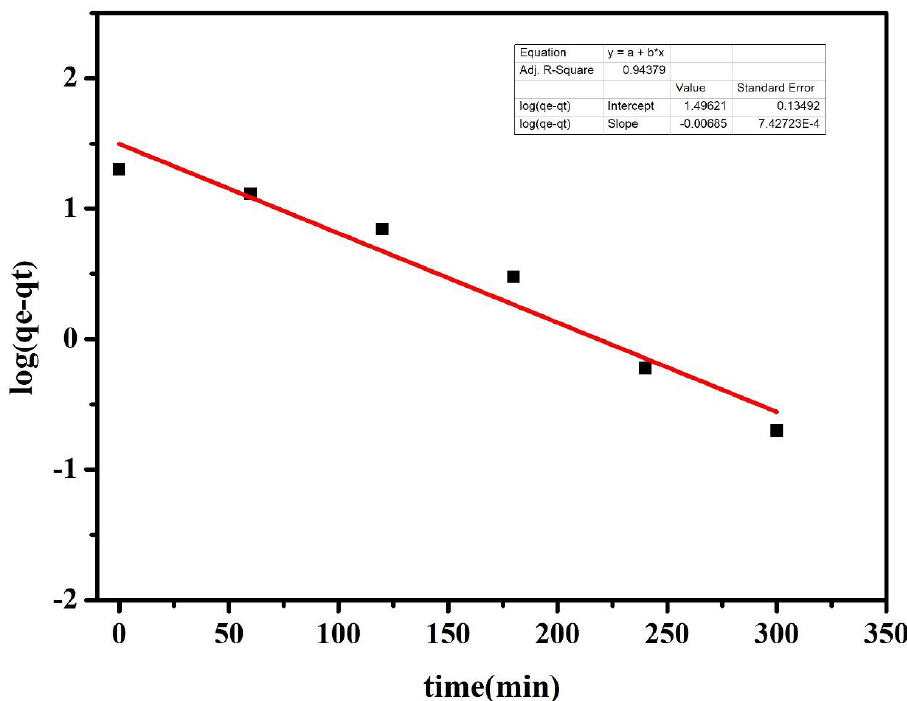
Figure 8. First – order kinetic model plot of log( q e − q t ) as a function of time (experiment in black; linear fit in red). Table 6. Details of the kinetic models during the adsorption of methylene blue on the